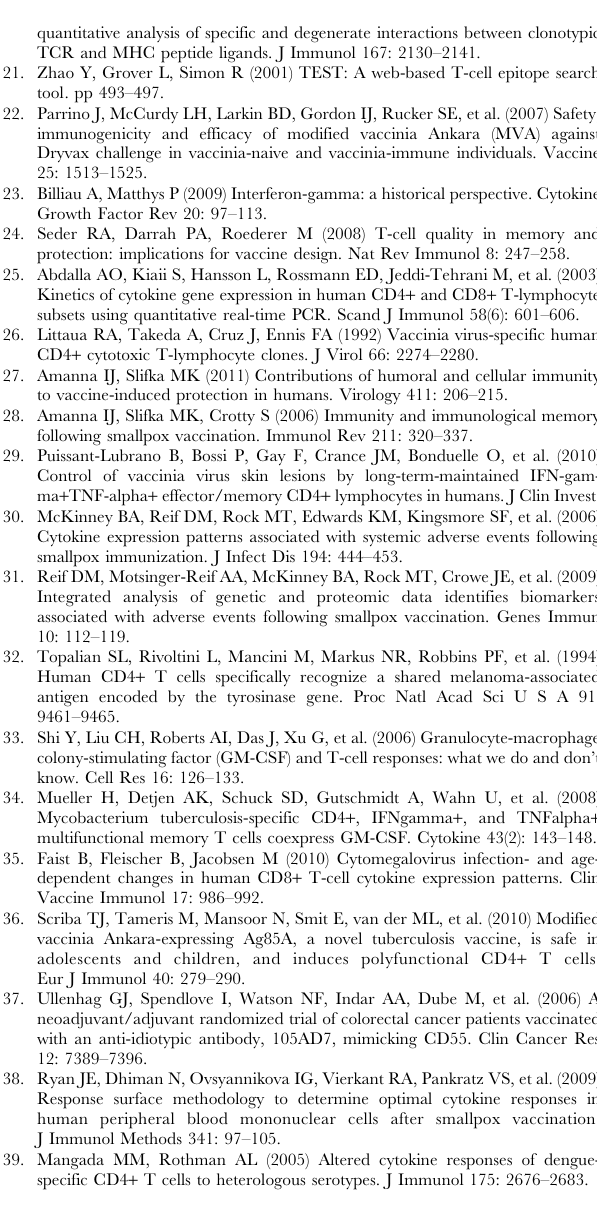
Table S1 Matrices derived from screening of decapep-